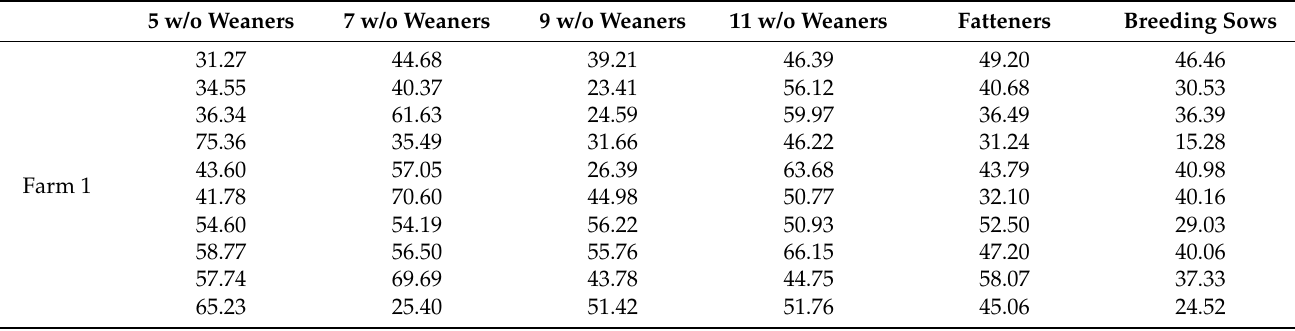
Table A1. Sera cortisol levels of individual pigs